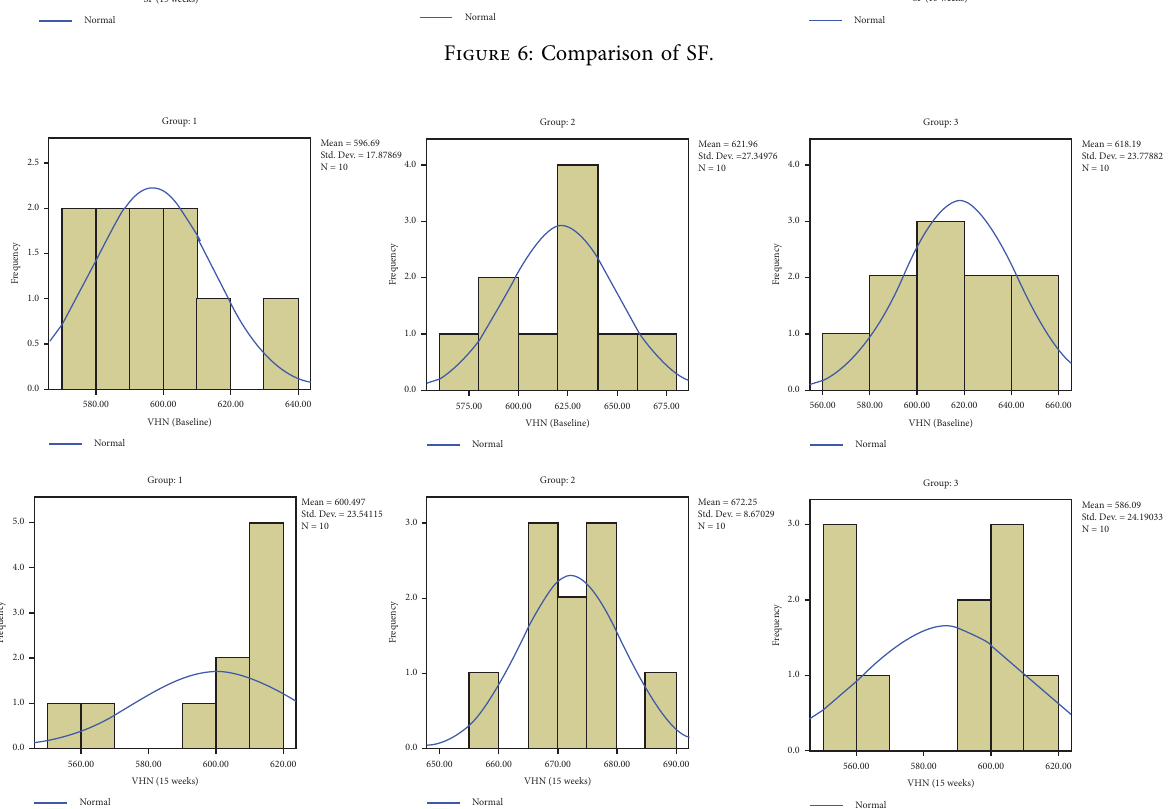
Figure 6: Comparison of SF.